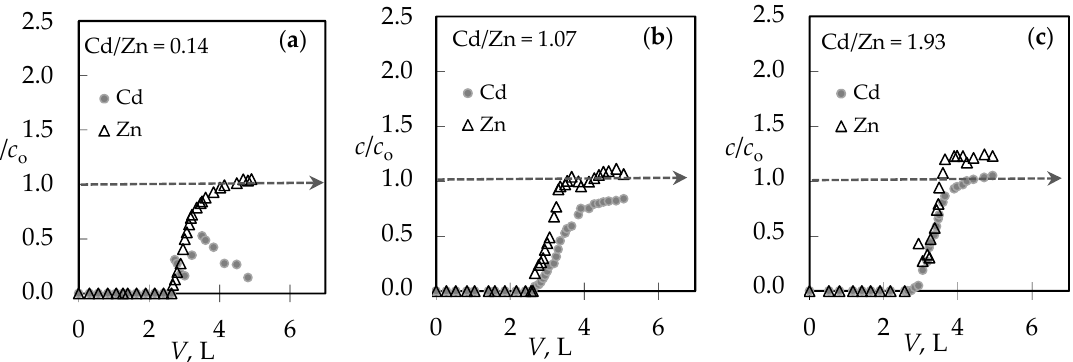
Figure 4 . The breakthrough curves for each metal ion in the binary (Cd + Zn) solution for different Cd/Zn ratios: ( a ) Cd/Zn = 0.14; ( b ) Cd/Zn = 1.07; and ( c ) Cd/Zn = 1.93. Note: c / c o = c (Cd)/ c o (Cd) or c (Zn)/ c o (Zn).